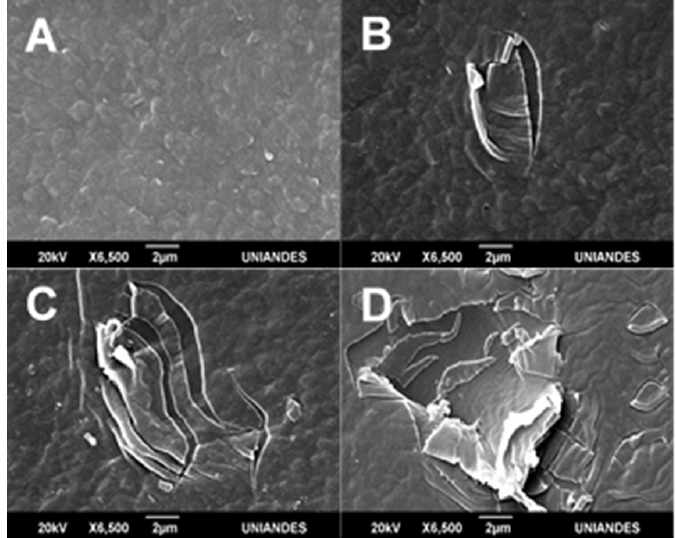
Figure 4. LDPE scanning electron microscopy (SEM) images submitted to Ar and O 2 plasma treat- ments. Pristine LDPE ( A ). LDPE submitted to Ar plasma ( B ). Ar–O 2 (1:1) mix ( C ). O 2 plasma treatment ( D